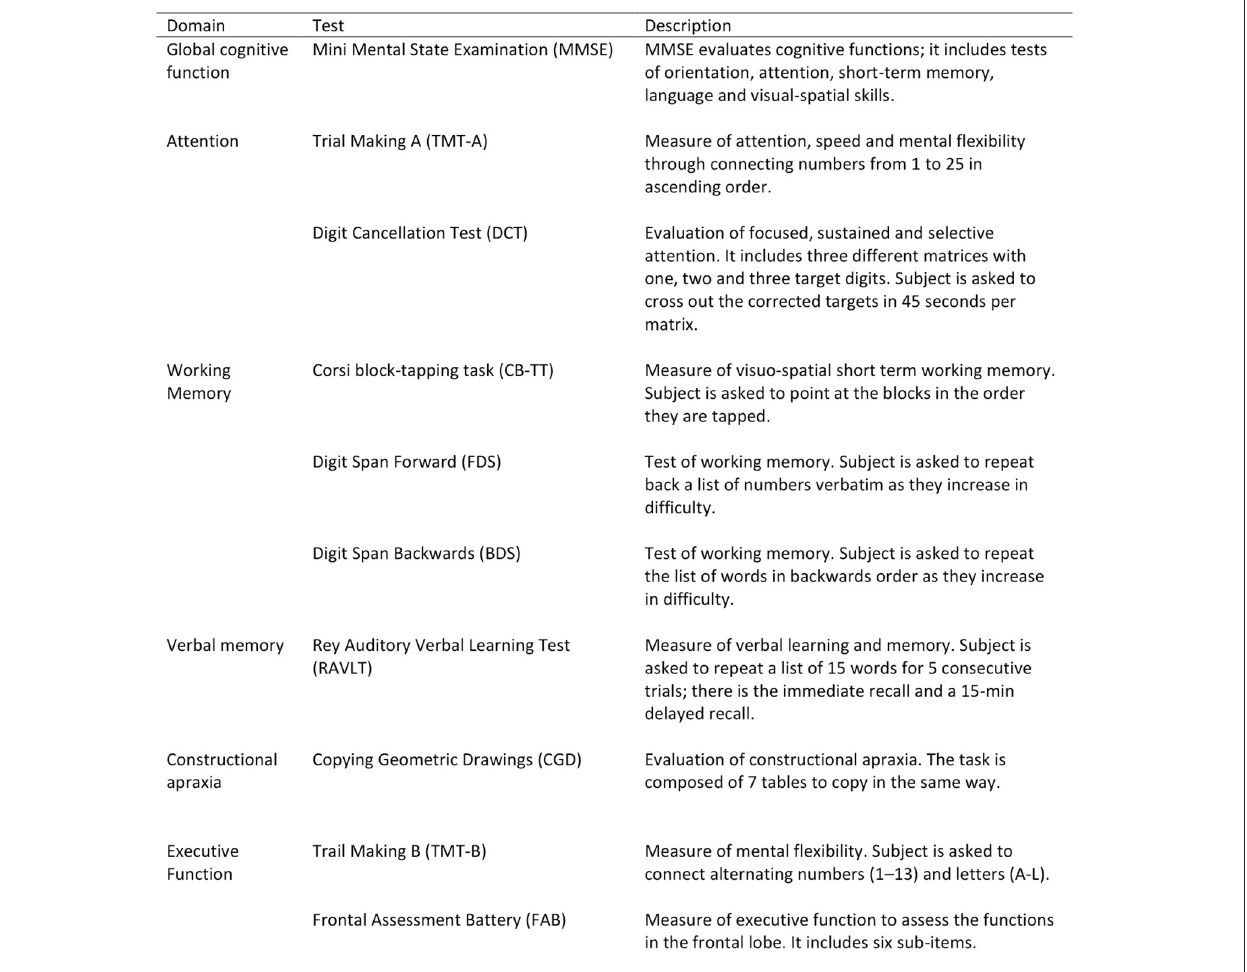
FIGURE 2 | Neurocognitive